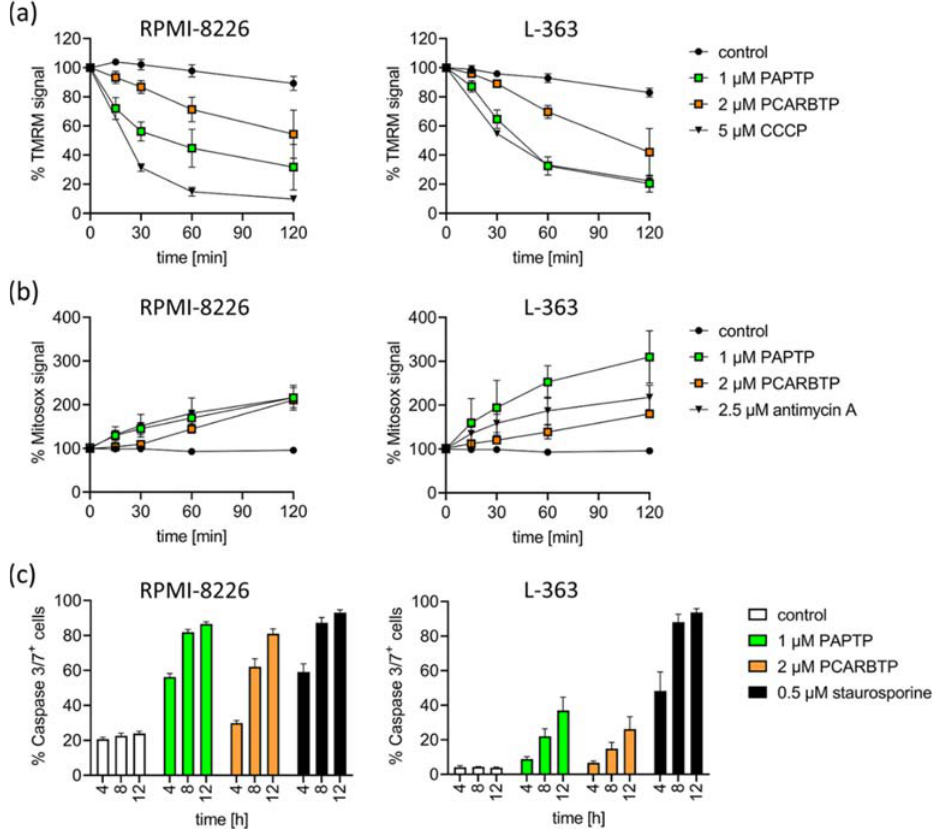
Figure 3. Inhibition of mitoKv1.3 with PAPTP and PCARBTP triggers apoptosis in human multiple myeloma cell lines L ‐ 363 and RPMI ‐ 8226. ( a ) Dissipation of the mitochondrial membrane potential was monitored following the TMRM signal over time. CCCP was used as the positive control. ( b ) Mitochondrial ROS production was monitored by the development of MitoSOX fluorescence over time. Antimycin A was used as the positive control. Values are reported as percentage MFI with respect to solvent control. ( c ) Caspase 3/7 ‐ activation was measured by flow cytometry 4, 8 and 12 h after treatment with PAPTP (1 μ M), PCARPTP (2 μ M) or staurosporine (0.5 μ M) as a positive control. Shown is the mean ± SD of % caspase 3/7+ cells of 3 independent experiments, each experiment in triplicate.